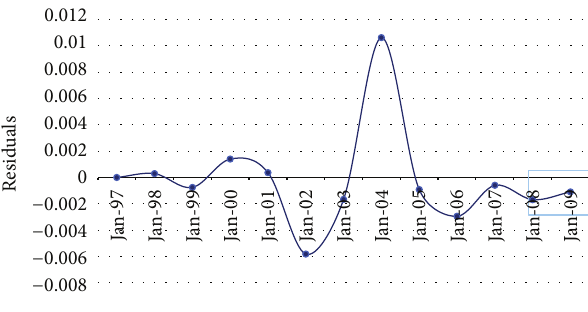
Figure 24: Residuals of the modified-hGP model in forecasting (2 years window period) of the number of OECD mobile contract